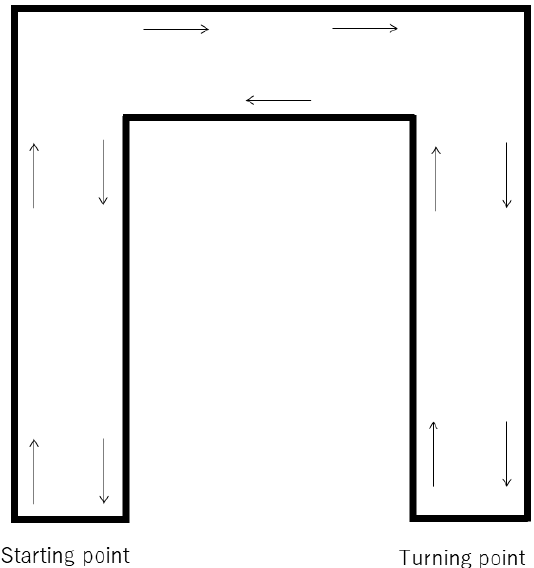
Figure 2. Outline of the U-shaped corridor used for the study’s delivery route. Each distance between the starting point and the first corner, the first and the second corner, and the second corner to the turning point was equal to 20 m. The total round-trip circuit was 120 m. The surface of the floor was rigid vinyl.